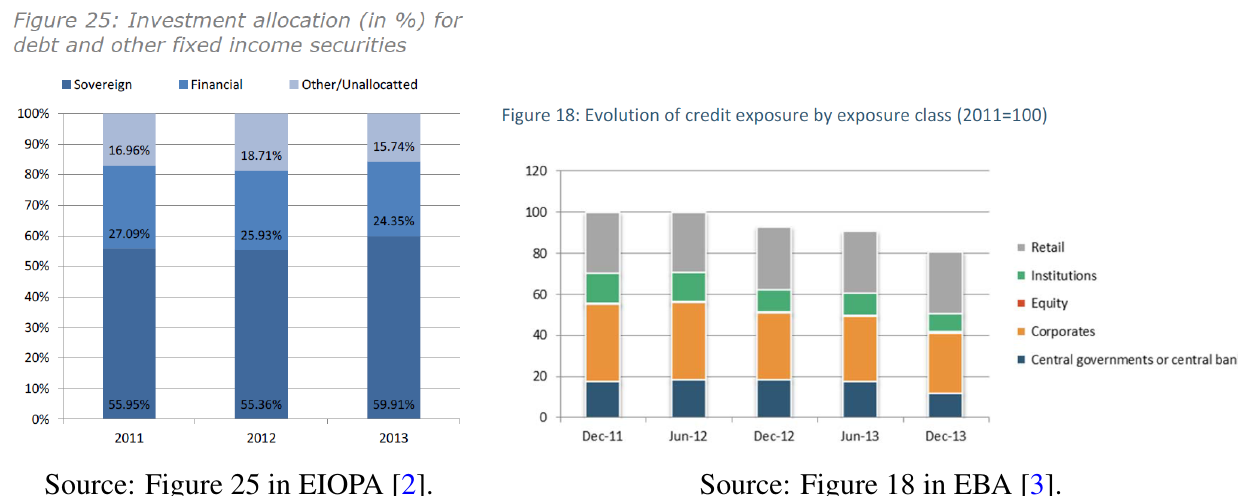
Figure 1. Aggregate breakdown of exposure allocation of the main European insurers and banks. ( a ) Investment allocation (in %) for debt and other fixed income securities for the European insurance sector; ( b ) evolution for credit exposure by exposure class (2011 = 100) for the European banking